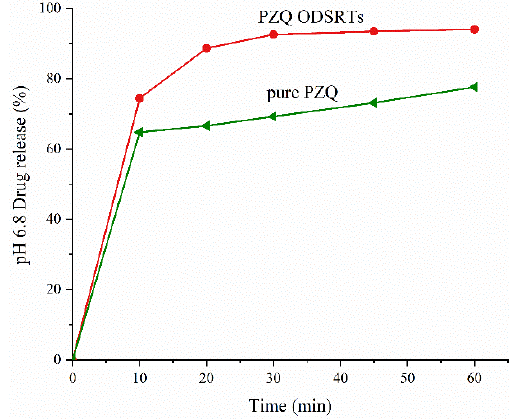
Figure 6. Drug release of PZQ ODSRTs and pure PZQ in buffer medium (pH 6.8).